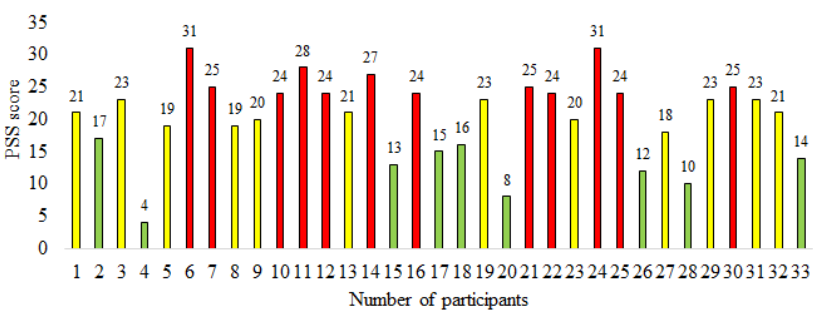
Figure 4. A graphical representation of Perceived Stress Scale (PSS) scores for participants showing labels